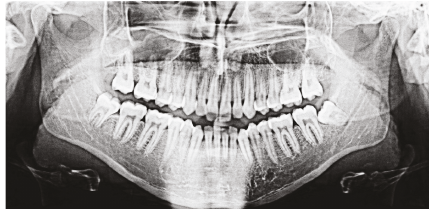
Figure 5: Panoramic X-ray before the excision of mucoepidermoid carcinoma.